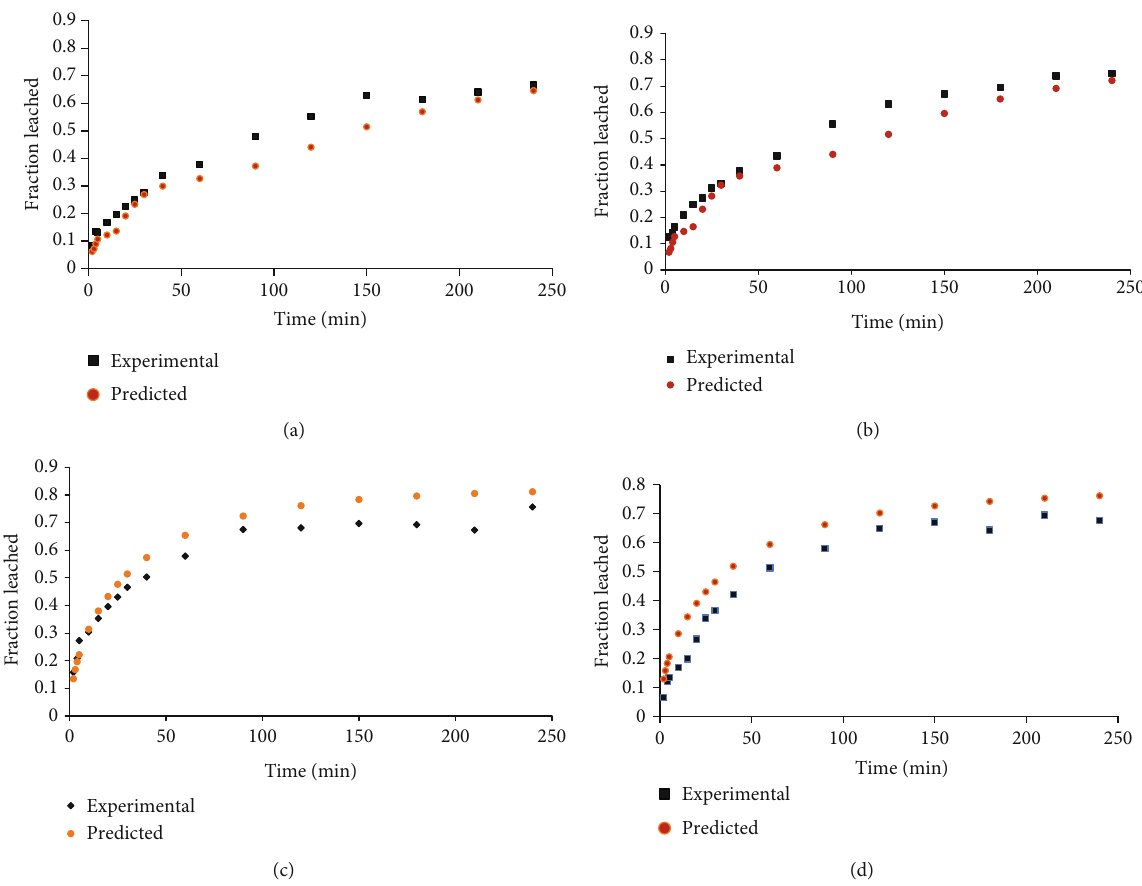
Figure 9: Experimental and predicted fraction of potassium leached from potato (a) cubes preheated at 80 ° C and leached at 30 ° C, (b) cubes preheated at 80 ° C and leached at 50 ° C, (c) cubes preheated and leached at 65 ° C, and (d) spheres preheated and leached at 70 °